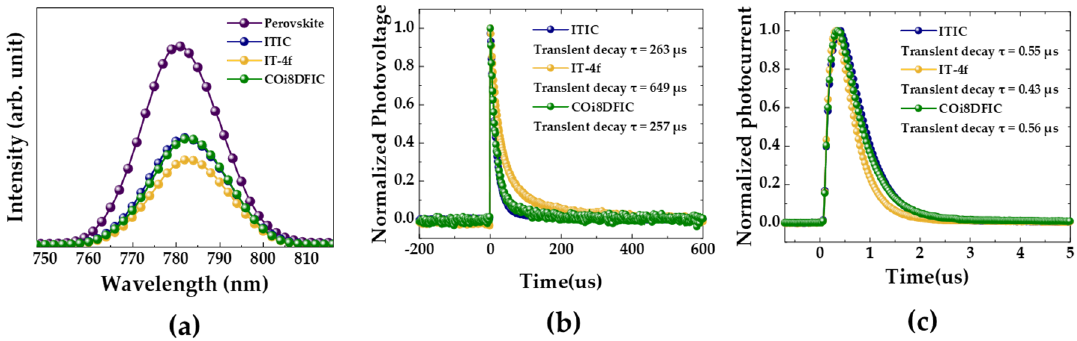
Figure 3. ( a ) Steady ‐ state photoluminescence (PL) spectra of the perovskite, perovskite/ITIC, perovskite/IT ‐ 4f, and perovskite/COi8DFIC. ( b ) Transient photovoltage (TPV) and ( c ) transient photocurrent (TPC) curves of the PSC with ITIC, IT ‐ 4f, and COi8DFIC as